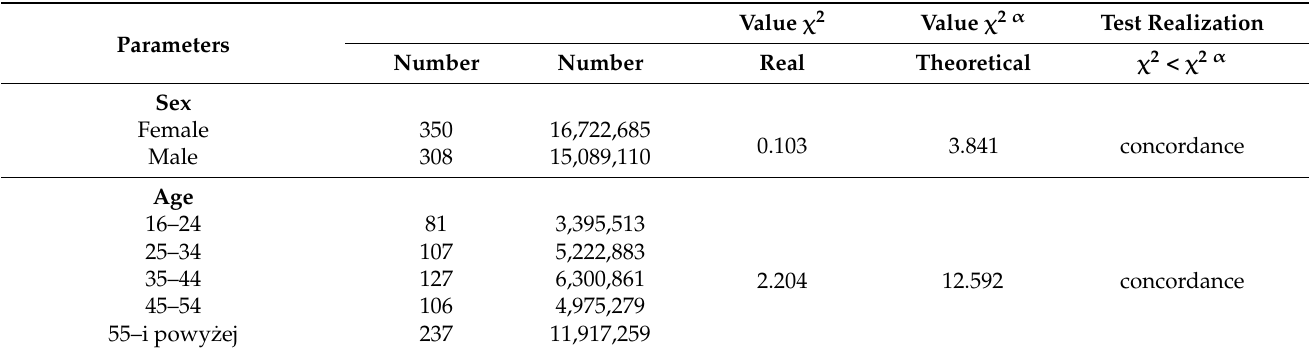
Table 2. Sample representativeness using statistical concordance test χ 2